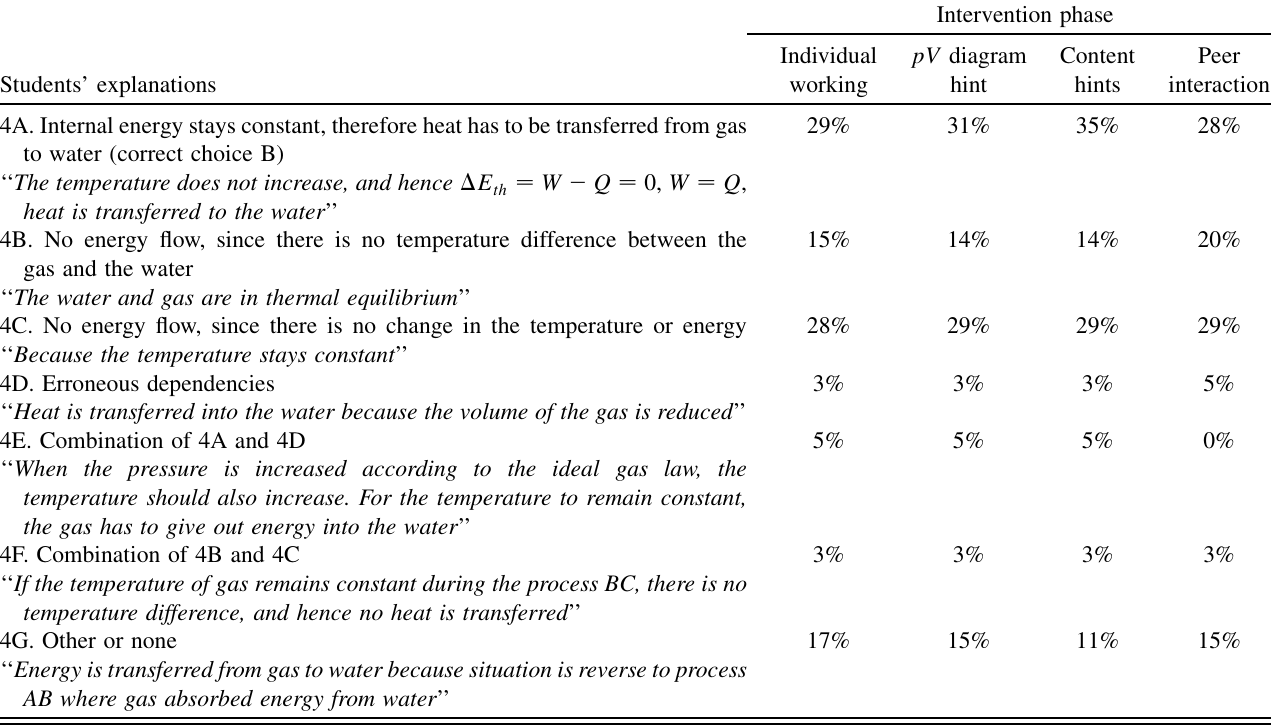
TABLE X. Students’ categorized explanations regarding the heat in an isothermal compression process. N ¼ 65 . A typical example from each category is presented after the category symbol in